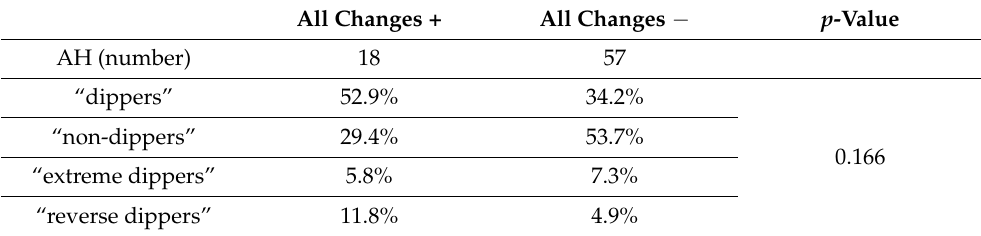
Figure 5. Maximum systolic blood pressure during the day and night and heart rate during the day in pre- and postmenopausal patients with arterial hypertension and in the region of the 12S RNA coding sequence. DDmaxRRs-daily maximum systolic blood pressure; NmaxRRs-nighttime maximum systolic blood pressure; DHR-daily heart rate; 12SrRNA+,-positive for 12SrRNA changes; 12SrRNA − ,-negative for 12SrRNA changes. Table 5. The incidence of hypertension subgroups (dippers, extreme dippers, reverse dippers, and non-dippers) depending on the presence of nucleotide sequence changes in